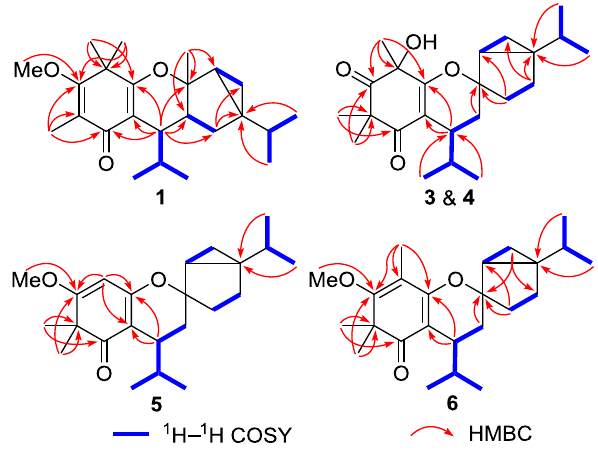
Fig. 2 Key 1 H– 1 H COSY and HMBC correlations of 1 and 3 – 6